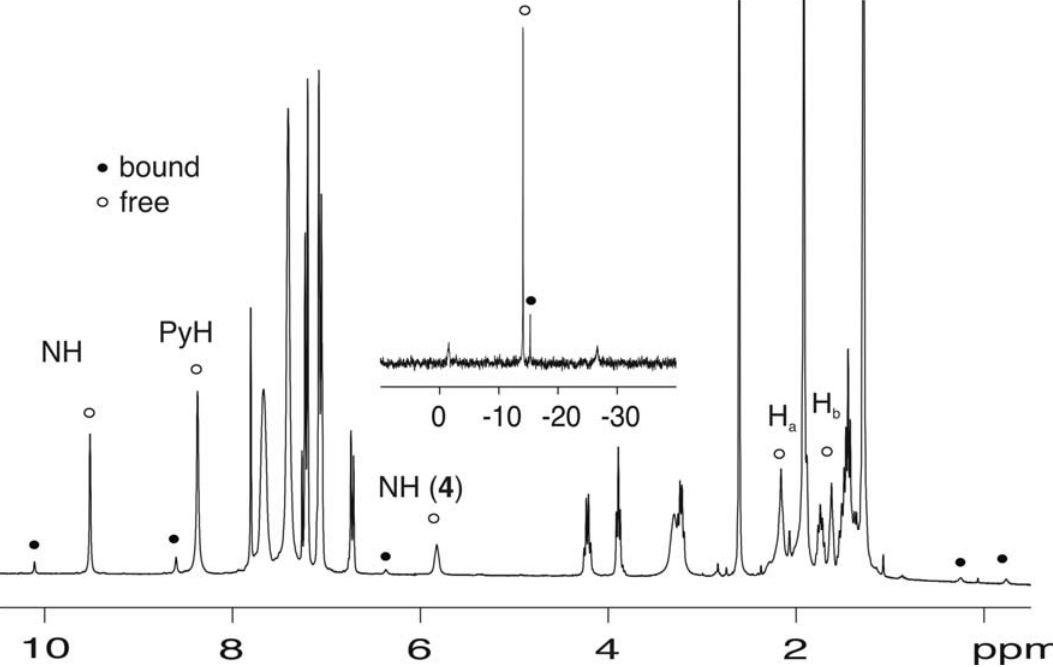
Figure 2. 1 H-NMR (300 MHz) spectra in CDCl showing free and bound species. Inset corresponding 31 P-NMR (121 MHz).